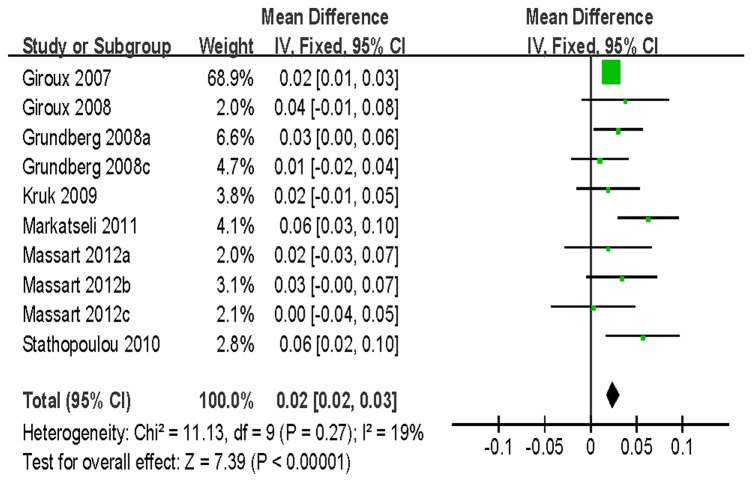
WMD and 95% CI in LS BMD between V667M VV and VM/MM genotypes.